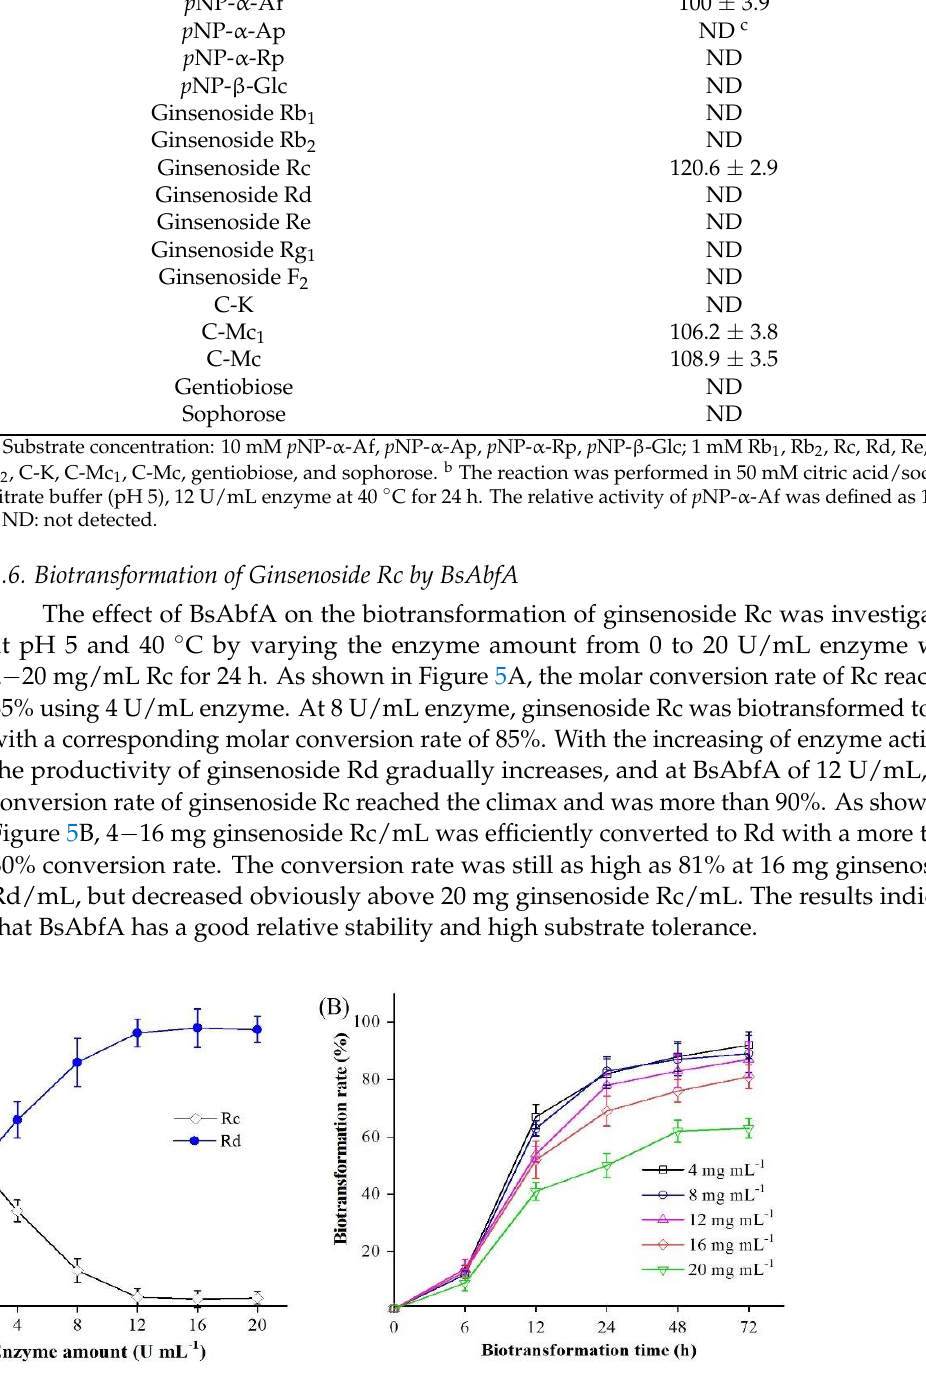
Figure 5. Effect of enzyme amount ( A ) and ginsenoside Rc concentration ( B ) on the production of Rd by using purified BsAbfA. ( A ) The reaction was performed in 50 mM citric acid/sodium citrate buffer (pH 5) containing 5 mM ginsenoside Rc and 0−20 U /mL enzyme at 40 °C for 24 h. ( B ) The reaction was performed in 50 mM citric acid/sodium citrate buffer (pH 5) containing 2−20 mg /mL ginsenoside Rc and 12 U/mL BsAbfA at 40 °C for 0−72 h. The data represent the means of three experiments, and error bars represent standard deviation.